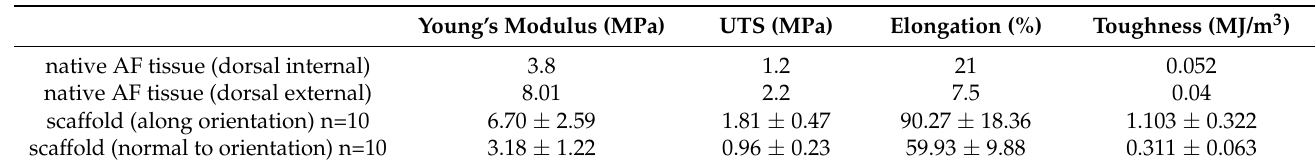
Table 1. Comparison of mechanical properties of dorsal site of native tissue and fibroin/gelatin electrospun scaffold.